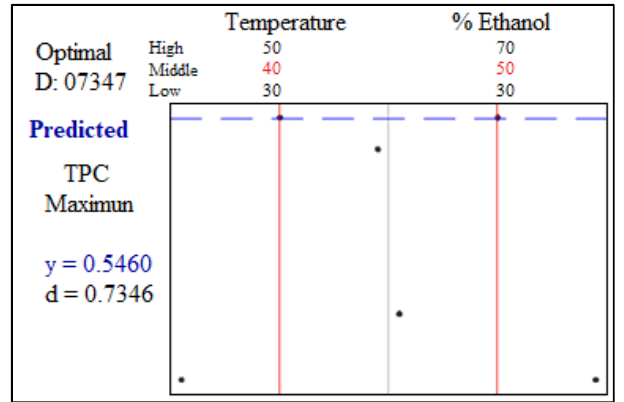
Figure 3. Total phenolic content (mg GAE/g extract) in the RBP extract at different temperatures and solvent concentrations. Same letters are not significantly different ( p ≤ 0.05).